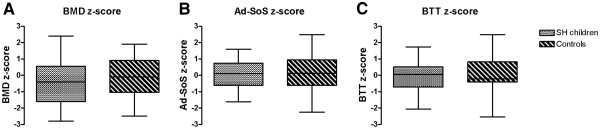
Bone mineral density (BMD) (A), and bone quality expressed by Ad-SoS (B) and BTT (C) Z-scores in children with subclinical hypothyroidism compared with the control group. (The boxes show medians, 25th and 75th percentiles, and the whiskers represent the highest and lowest values).